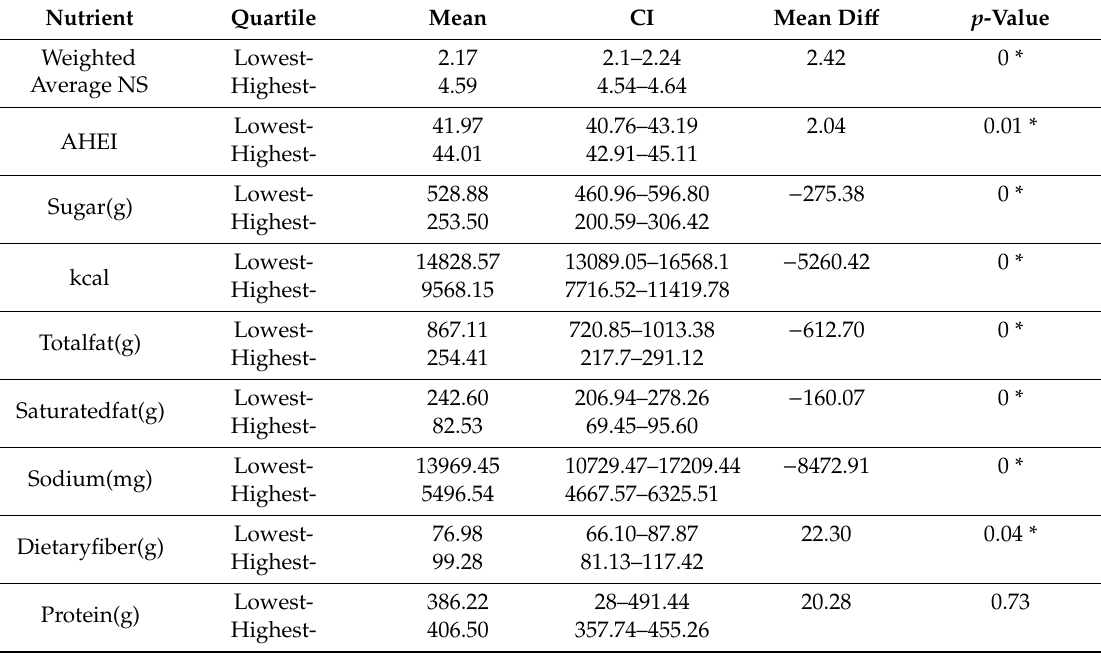
Table A10. Comparison between lowest (least healthy) and highest (healthiest) quartile of shopping baskets by weighted average Nutri-Score